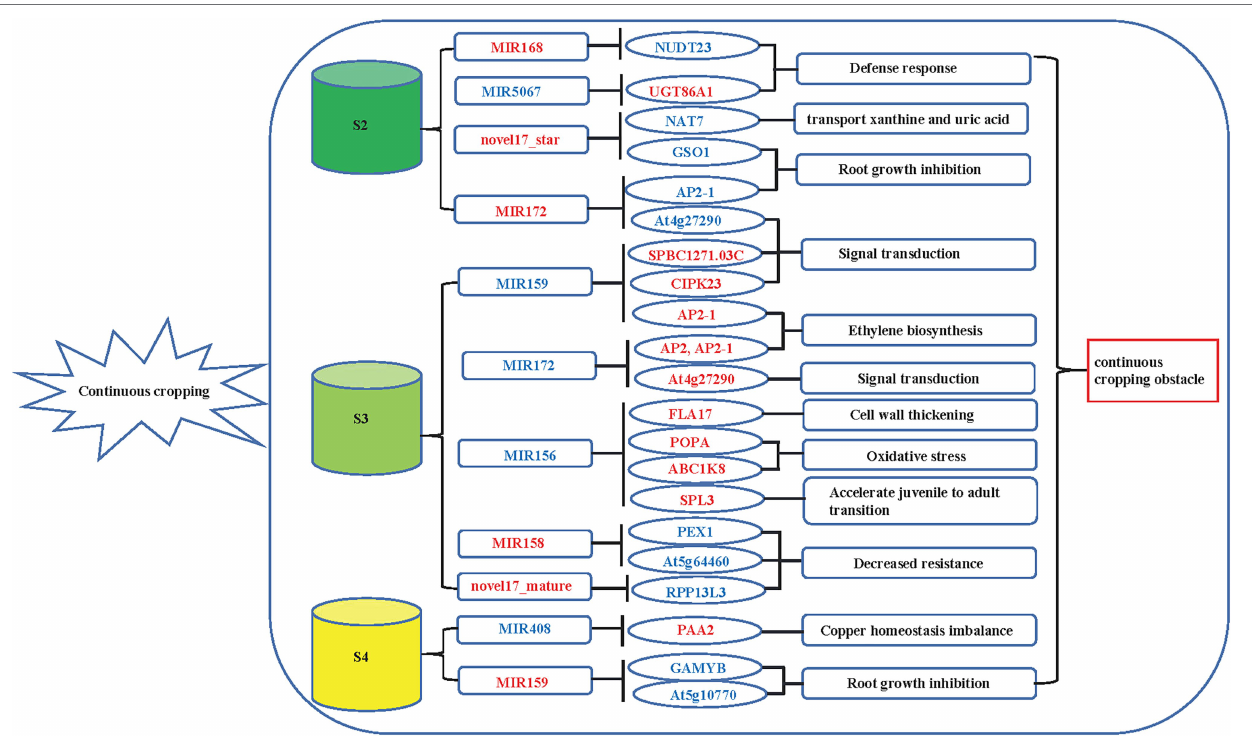
FIGURE 6 | Quantitative real-time PCR (qRT-PCR) analysis of DEGs. The error bar represents the error values of three biological replicates.